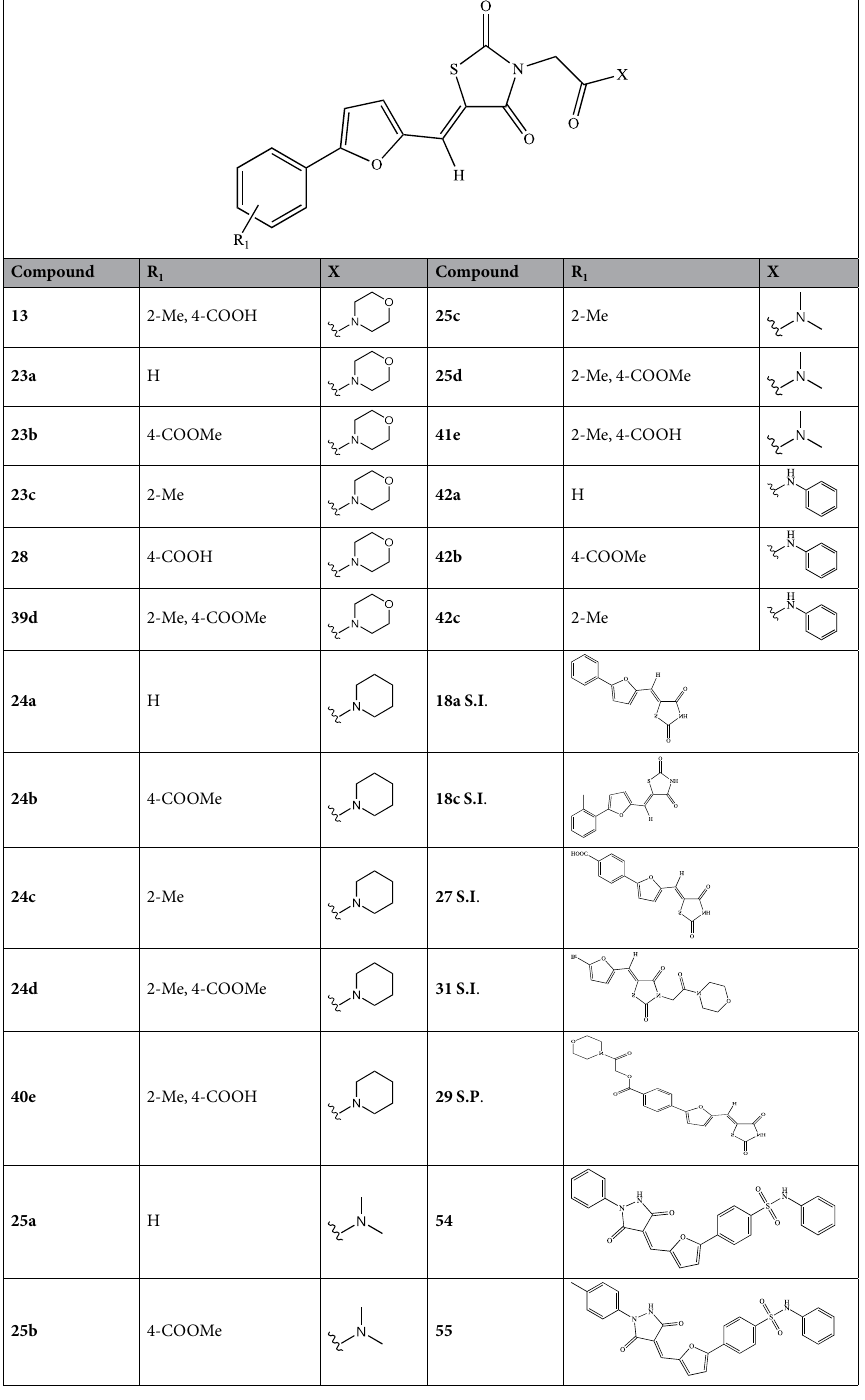
Table 1. Newly prepared compounds evaluated on recombinant norovirus Sydney 2012 RdRp activity in vitro assay. S.I. = synthesis intermediate; S.P. = side